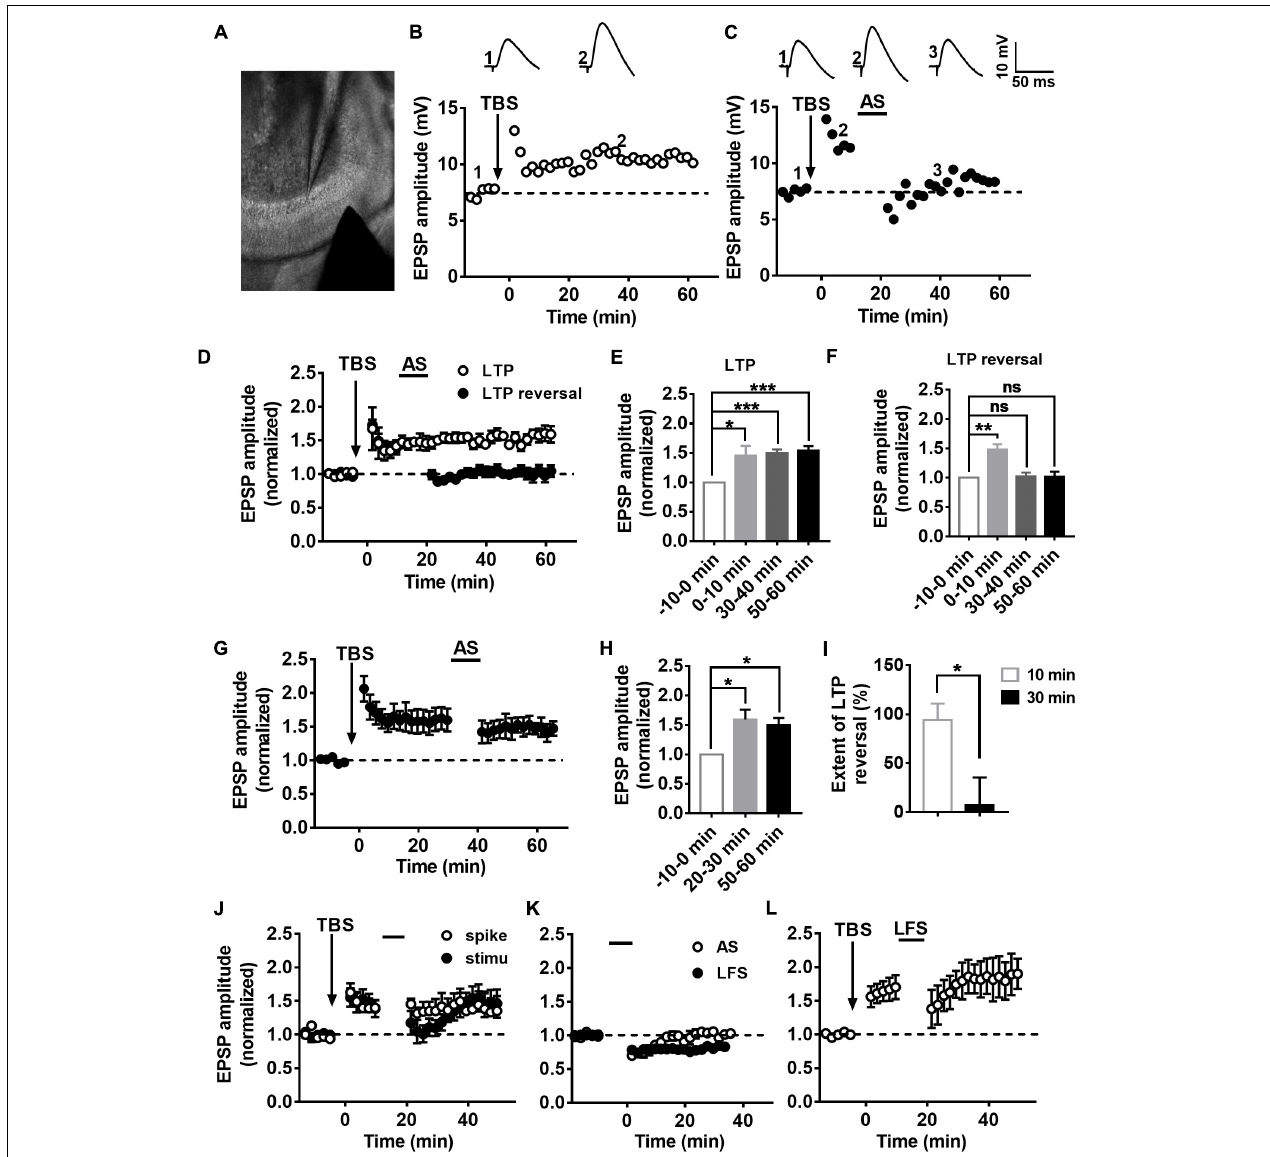
FIGURE 1 | Characteristics of LTP and LTP reversal in the DGCs of the adult mouse hippocampus. (A) A photograph of the EPSP recording setup by whole-cell patch-clamp in adult mouse hippocampal DGCs. (A,B) LTP (B) and LTP reversal (C) were recorded from mature DGCs at the adult brain. Shown in the top row are typical example traces of LTP of EPSPs recorded under the whole-cell current-clamp. Representative EPSPs were taken before and after LTP induction by a physiological relevant TBS (arrow) at specific time points (1 and 2) or after LTP reversal by a combination of presynaptic stimulation and postsynaptic spikes (AS,